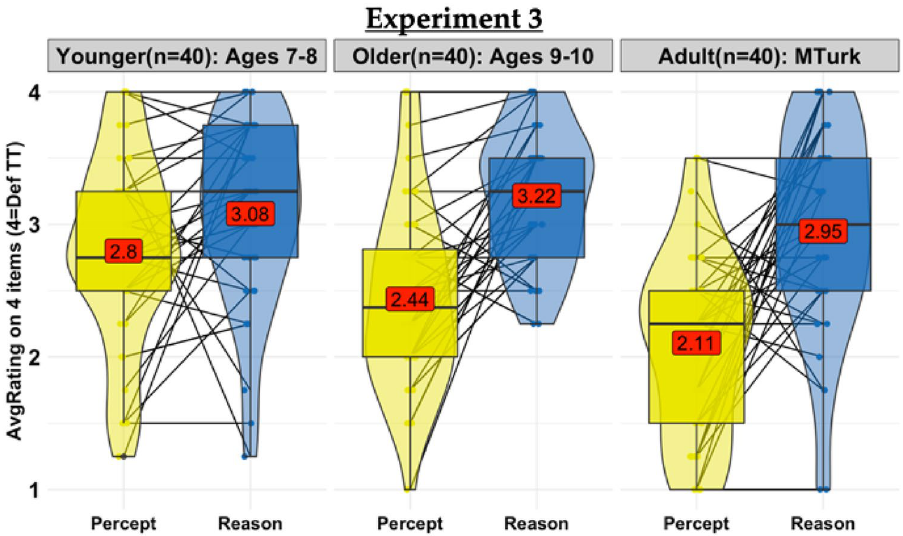
Figure 3. Experiment 3: Results. Preference for 5-person group discussion or independent crowd poll of 50 people, averaged across four Easy Reasoning questions (blue boxplots) and four Hard Perceptual Discrimination questions (yellow boxplots). Higher ratings indicate stronger preference for group discussion. Boxplots showing median and interquartile range overlay violin plots; red labels show means; black lines show within-subject differences for the average rating by question Type